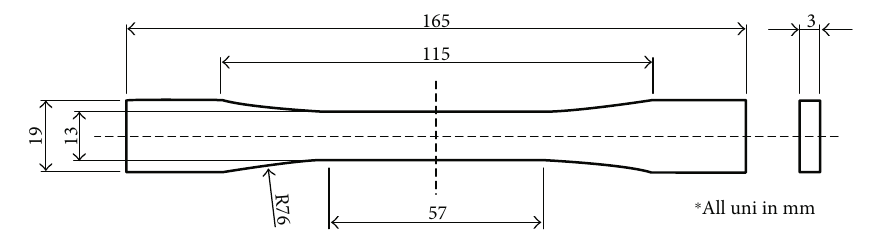
Figure 1: Dimensions of the tensile test specimen (ASTM D638 type I).